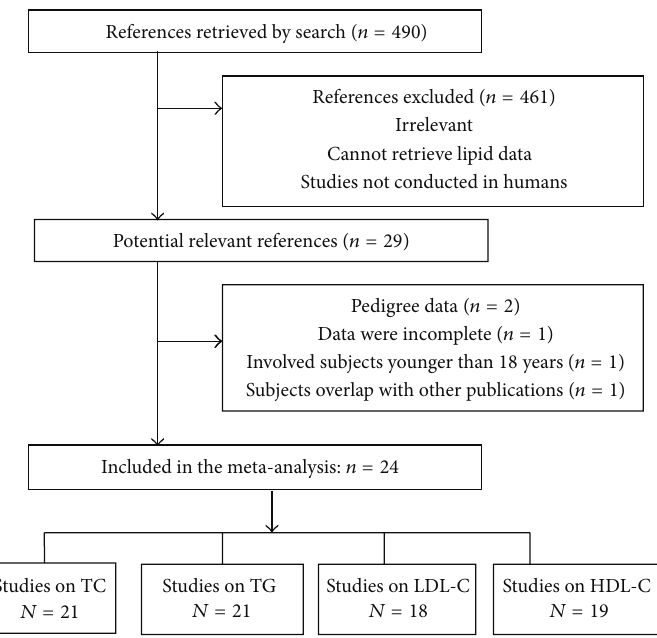
Figure 1: Flowchart outlining the process of search criteria and study